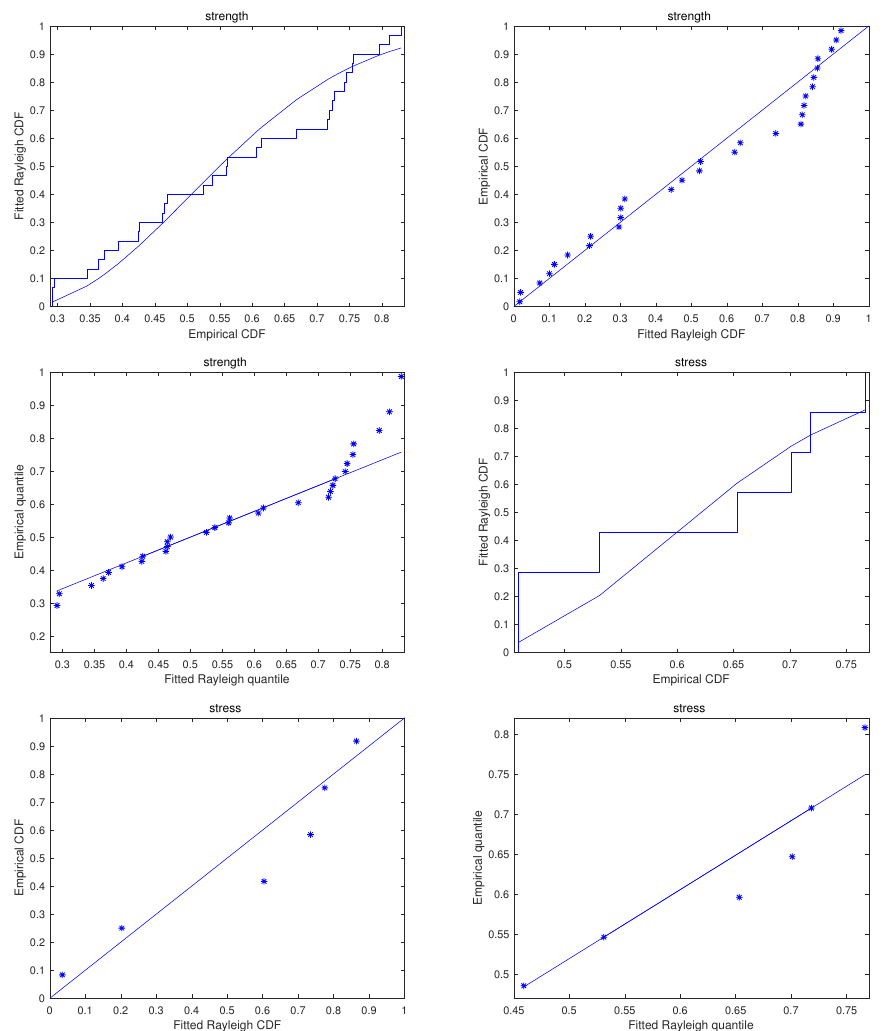
Figure 1. Empirical distribution and fitted Rayleigh distribution, P-P, and Q-Q plots based on real